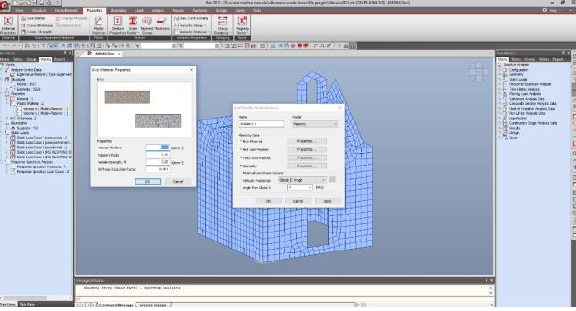
Figure 11. Non linear materials